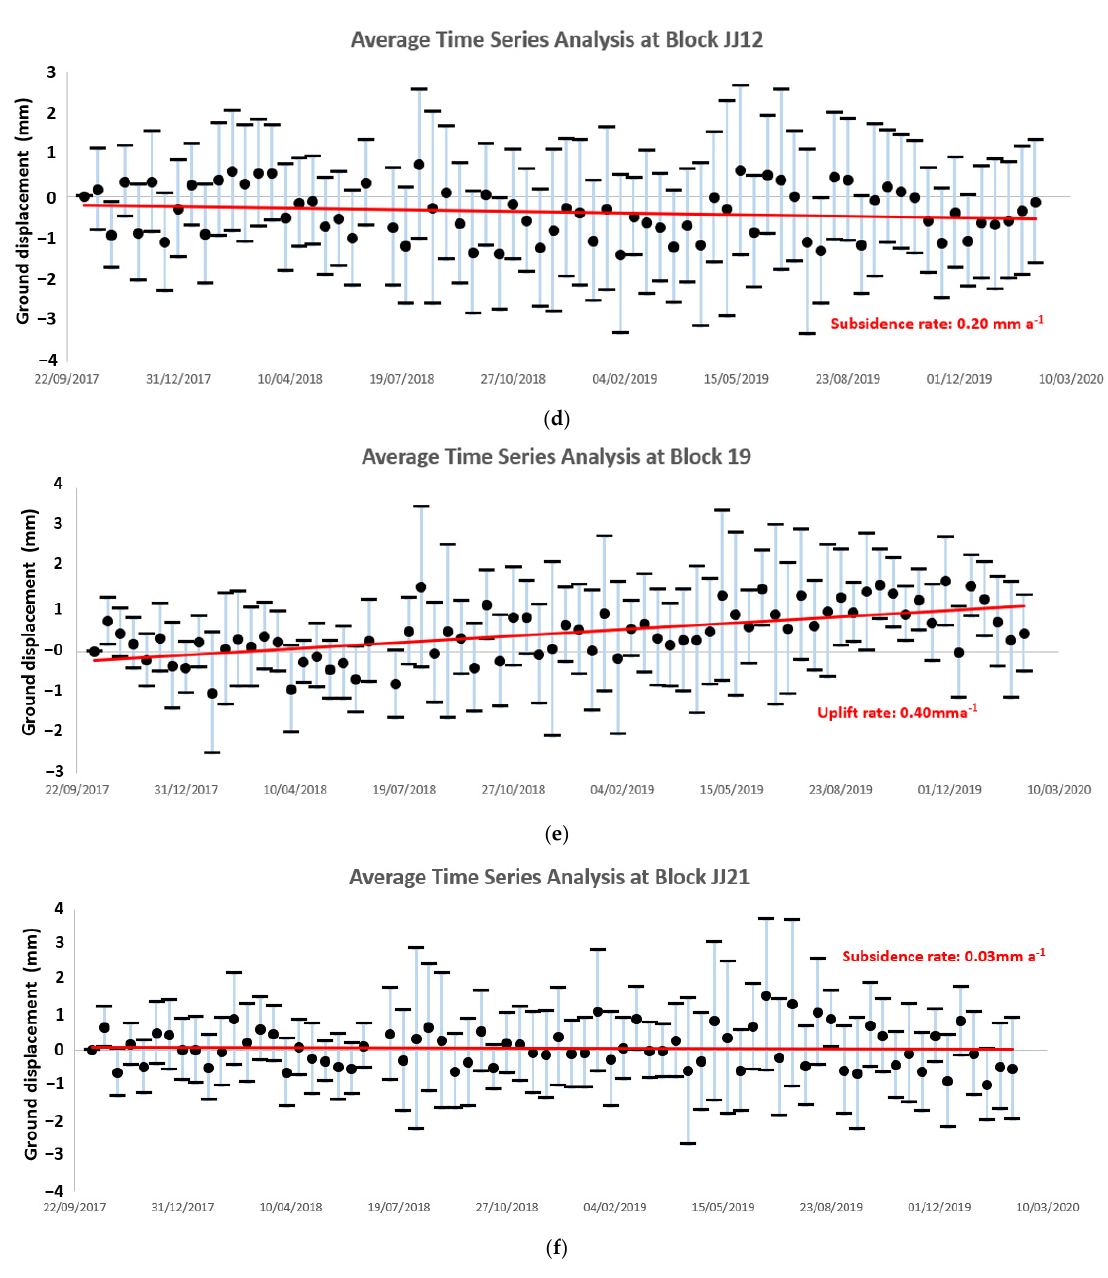
Figure 9. ( a – f ). ( a ) The average time-series analysis for JJ6 along F a . JJ6 subsided by 0.5 mm from October 2017 to February 2020, equivalent to an annual rate around 0.2 mm; ( b ) the average time- series analysis for JJ7 along F a . JJ7 uplifted by 0.2 mm from October 2017 to February 2020, equivalent to an annual rate of about 0.07 mm; ( c ) the average time-series analysis for JJ3 along F g . JJ3 uplifted by 1.0 mm from October 2017 to February 2020, equivalent to an annual rate of about 0.40 mm; ( d ) the average time-series analysis for JJ12 along F g . JJ12 subsided by 0.5 mm from October 2017 to February 2020, equivalent to an annual rate of about 0.2 mm a − 1 ; ( e ) the average time-series analysis for JJ19 along F m , F n , and F o . JJ19 uplifted by 1 mm from October 2017 to February 2020, equivalent to an annual rate around 0.40 mm; ( f ) The average time-series analysis for JJ21 along F m , F n and F o suggests JJ21 subsided slightly by 0.03 mm a − 1 from October 2017 to February